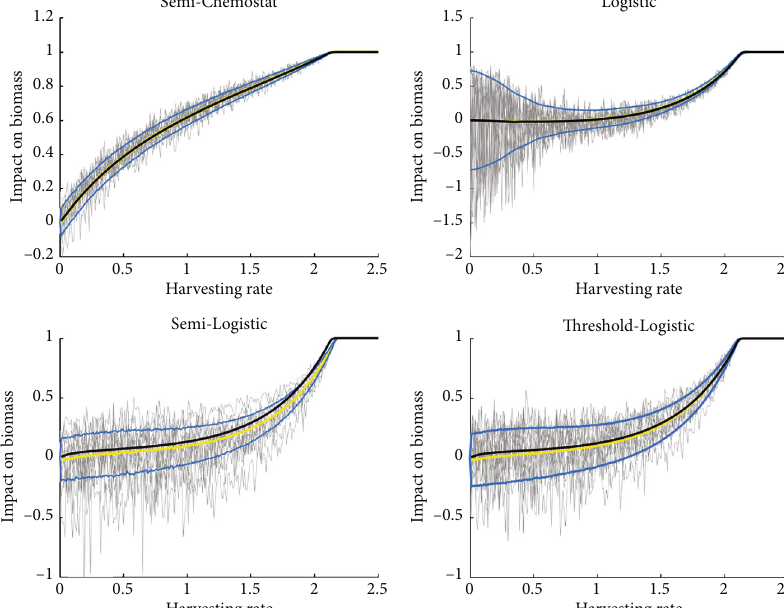
Figure 14: Impact on biomass of semichemostat, logistic, semilogistic, and threshold-logistic growth rate at steady state w.r.t. harvesting rate. The grey trajectories show the impact on biomass from di ff erent simulations for the stochastic case. The yellow curve represents the mean value of the simulation. The light blue curves represent the interval of standard deviation (68%). The black curve represents the impact on biomass for the deterministic case. The above graphs are calculated using equation